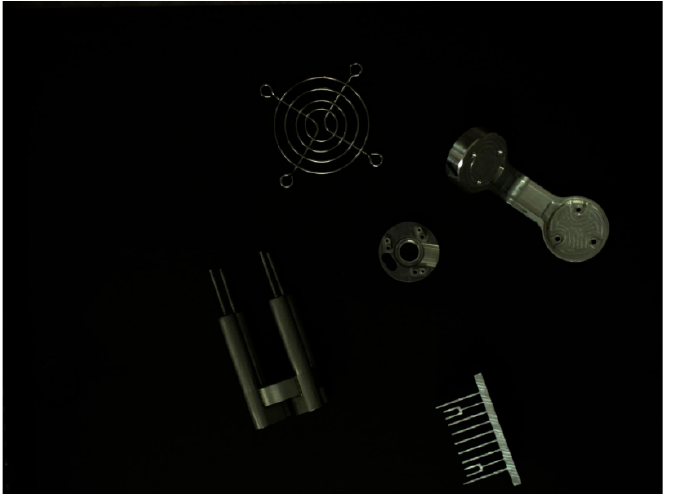
Figure 13. Example of an input image.